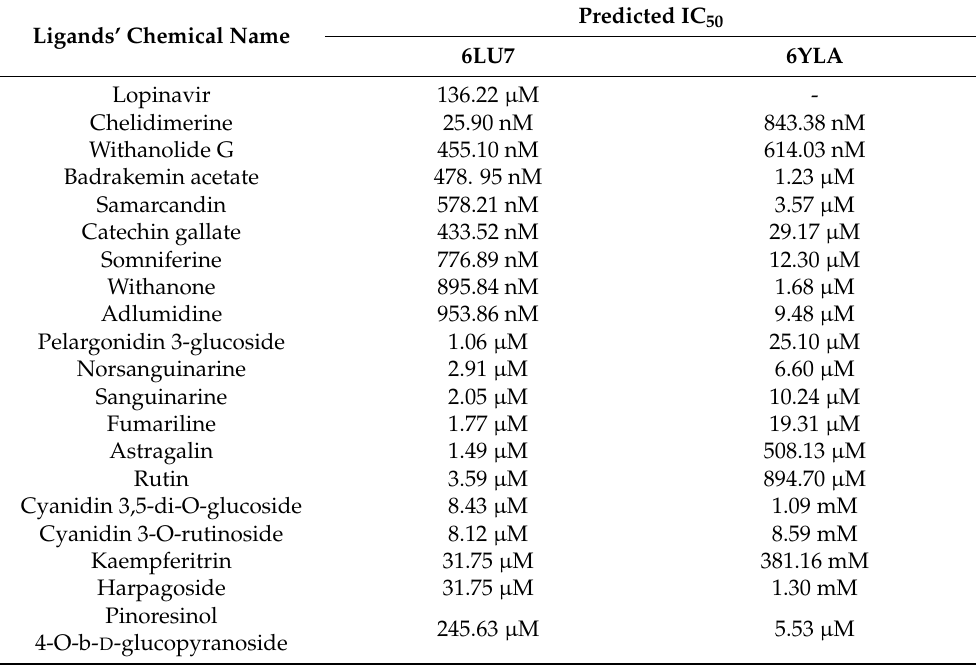
Table 5. Predicted half-maximal inhibitory concentration (IC50)